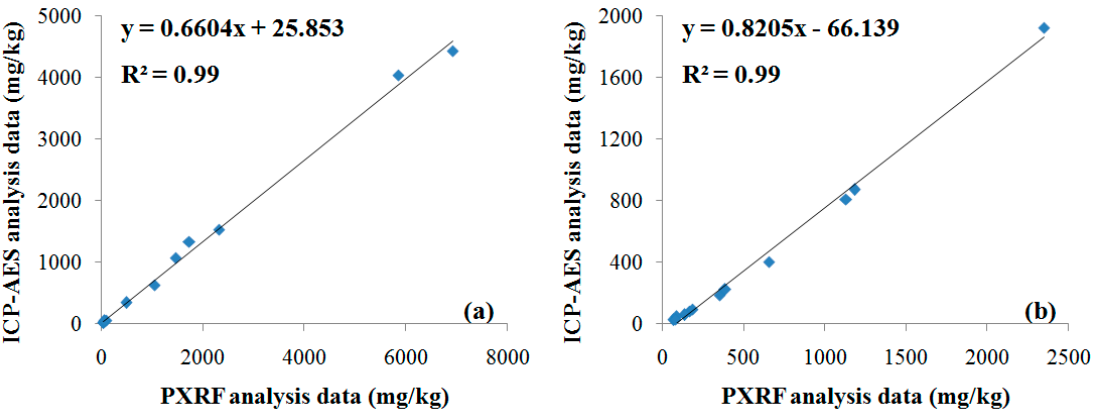
Figure 4. Graphs showing the correlation of ICP–AES and PXRF analysis data for: ( a ) copper; and ( b ) lead.